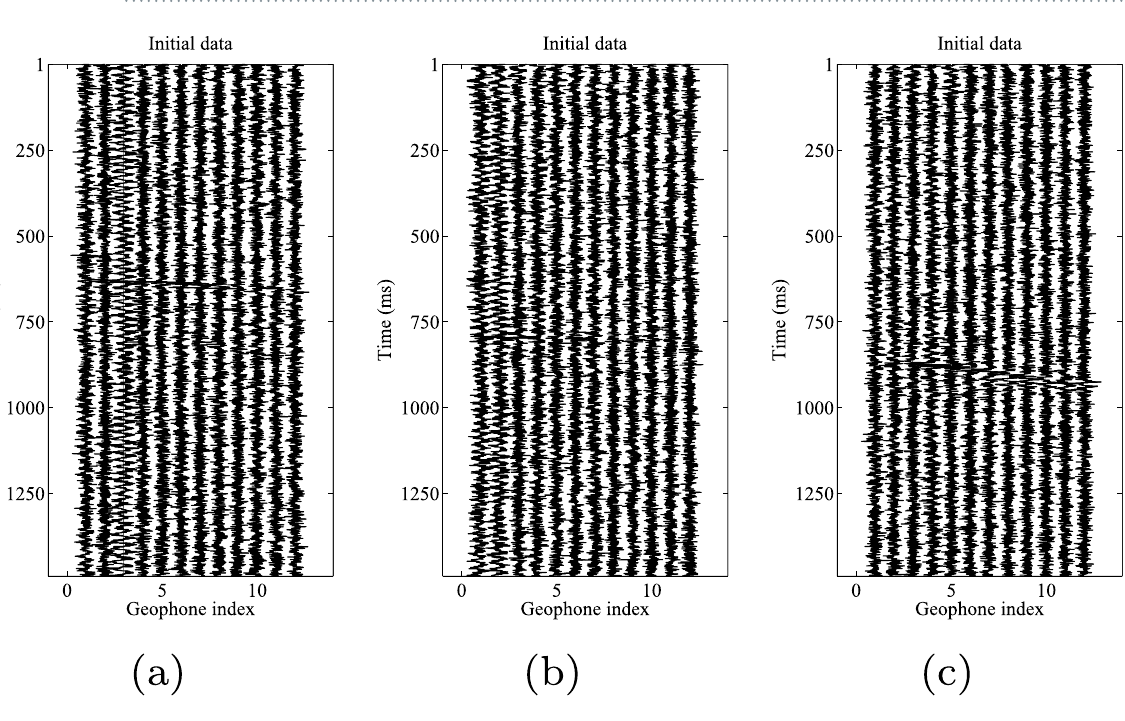
Figure 8. 3-C microseismic data. ( a ) Horizontal components (H1). ( b ) Horizontal components (H2). ( c ) Vertical component